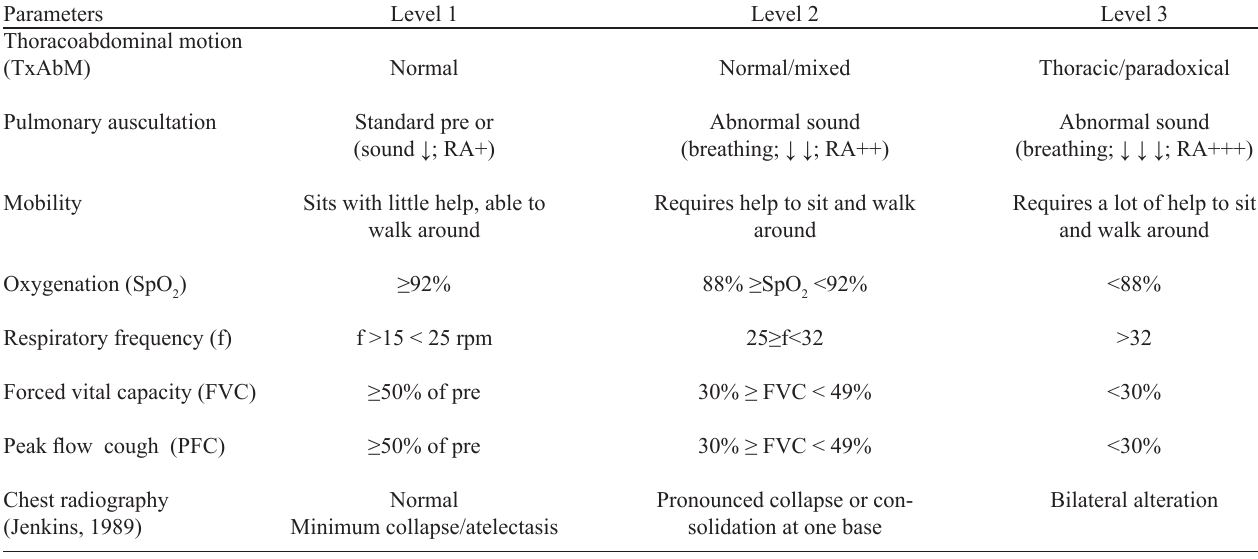
Table 1. Parameters for clinical and functional evaluations to define the degree of pulmonary